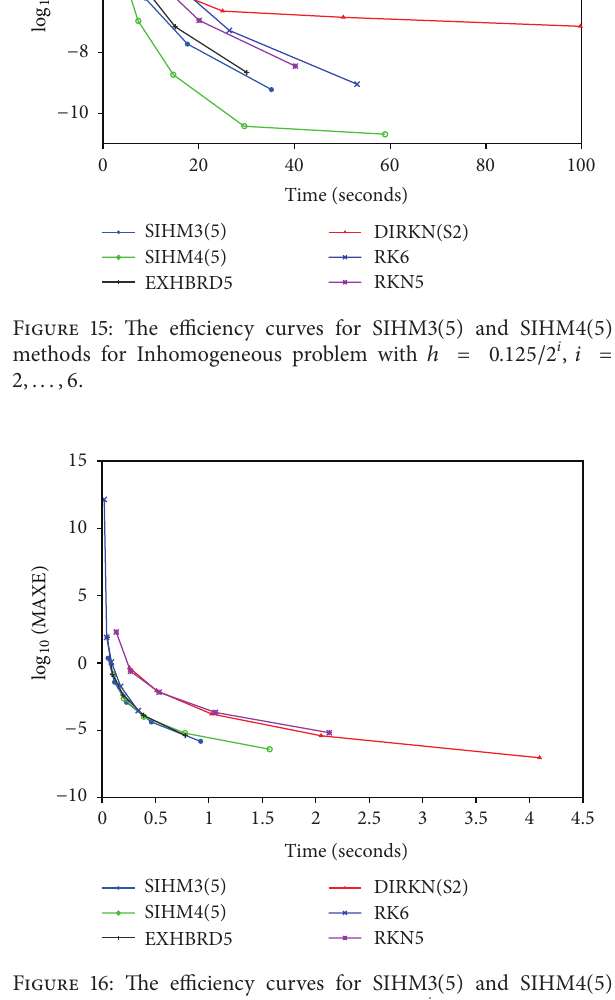
Figure 16: The efficiency curves for SIHM3 (5) and SIHM4 (5) methods for Orbital problem with ℎ = 0.125/2 𝑖 , 𝑖 = 4,...,8